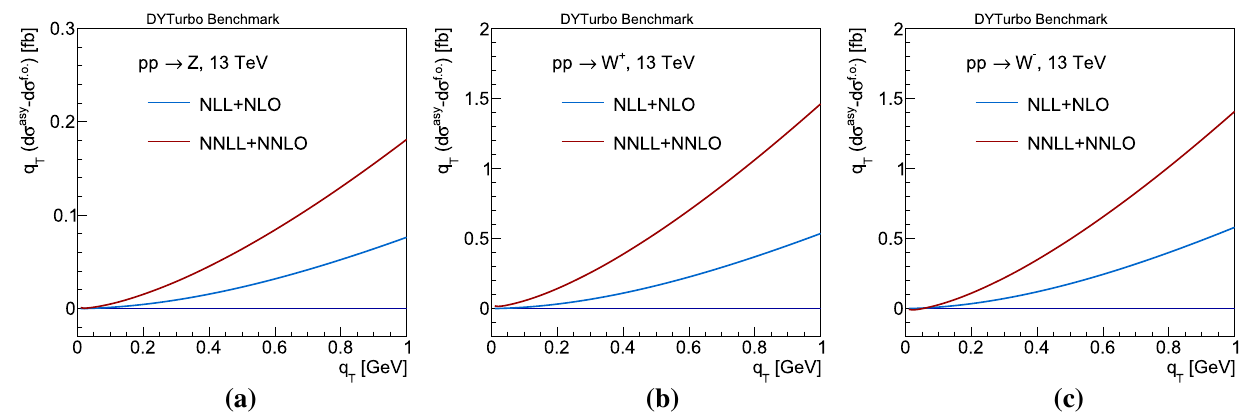
Fig. 3 Closure test of the relation d σ asy ∼ d σ f.o. when q T → 0 for a Z /γ ∗ -boson, b positively-charged W -boson, and c negatively-charged √ W -boson production at s = 13